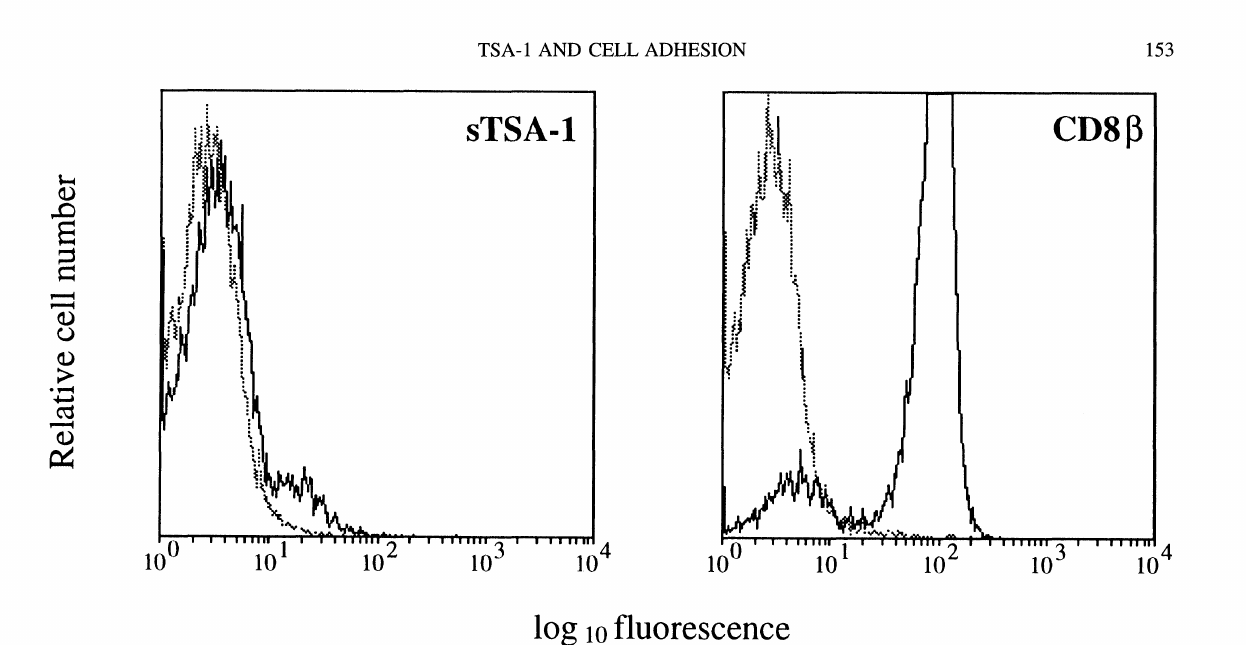
FIGURE 3 A putative cell-surface ligand for TSA-1 expressed on a subpopulation of thymocytes. Thymocytes were labeled with a preformed complex of sTSA-1 and OX8-biotin (see Materials and Methods), and the bound complex was detected with phycoerythrin- conjugated